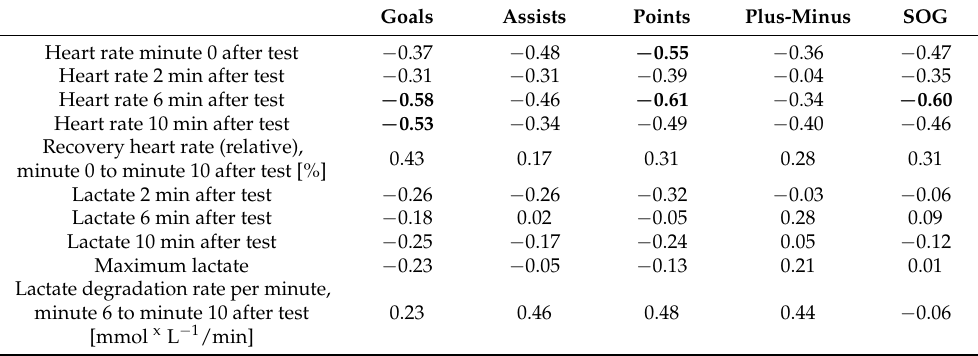
Table 5. Bivariate correlations (r) between on-ice testing variables (stress parameters) and selected match performance variables. Relevant correlations (r ≥ 0.5) marked in bold. SOG = shots on goal.